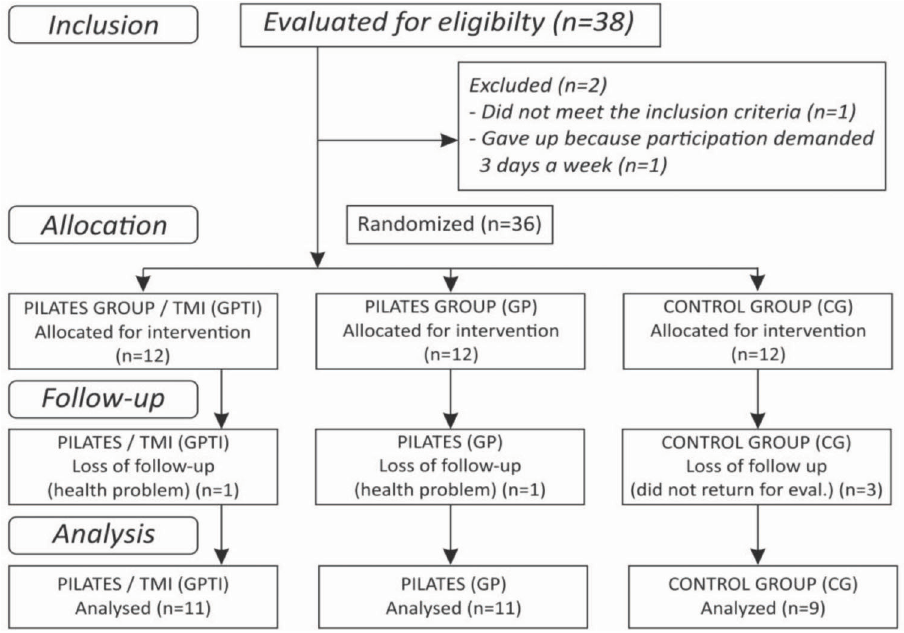
Figure 1 - Flow Diagram